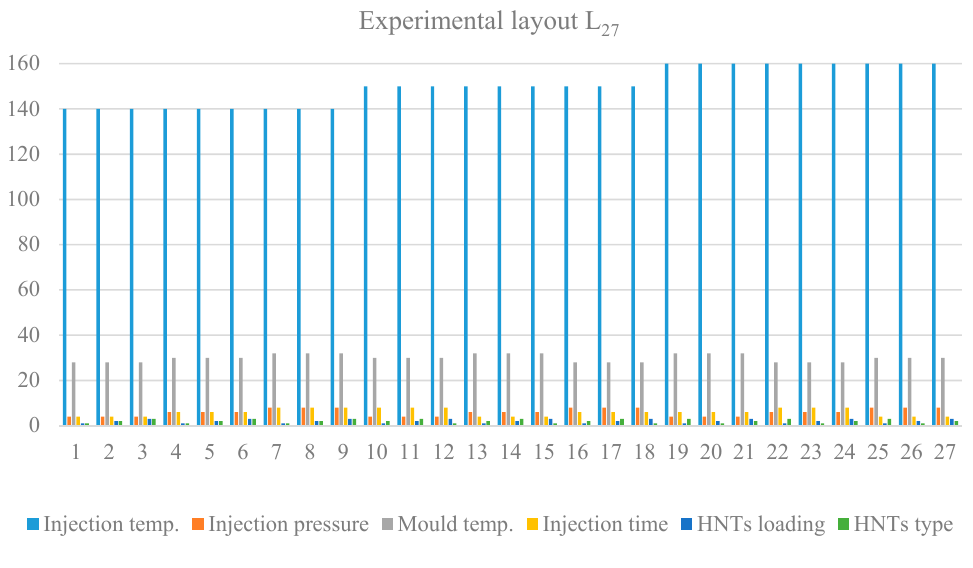
Figure 2. The experimental layout (L 27 (3 13 )) Taguchi model for experimentation.